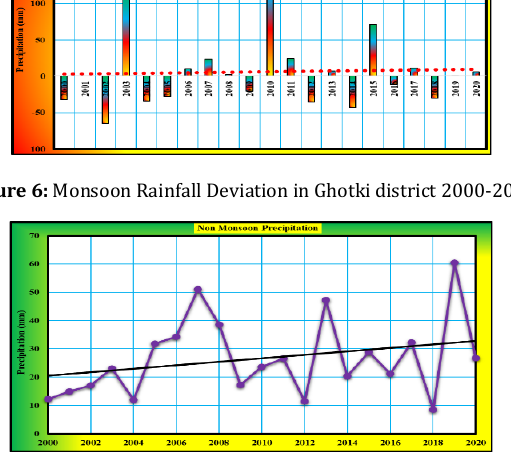
Figure 7: Represents Non-Monsoon rainfall trend line from 2000-2020 in district